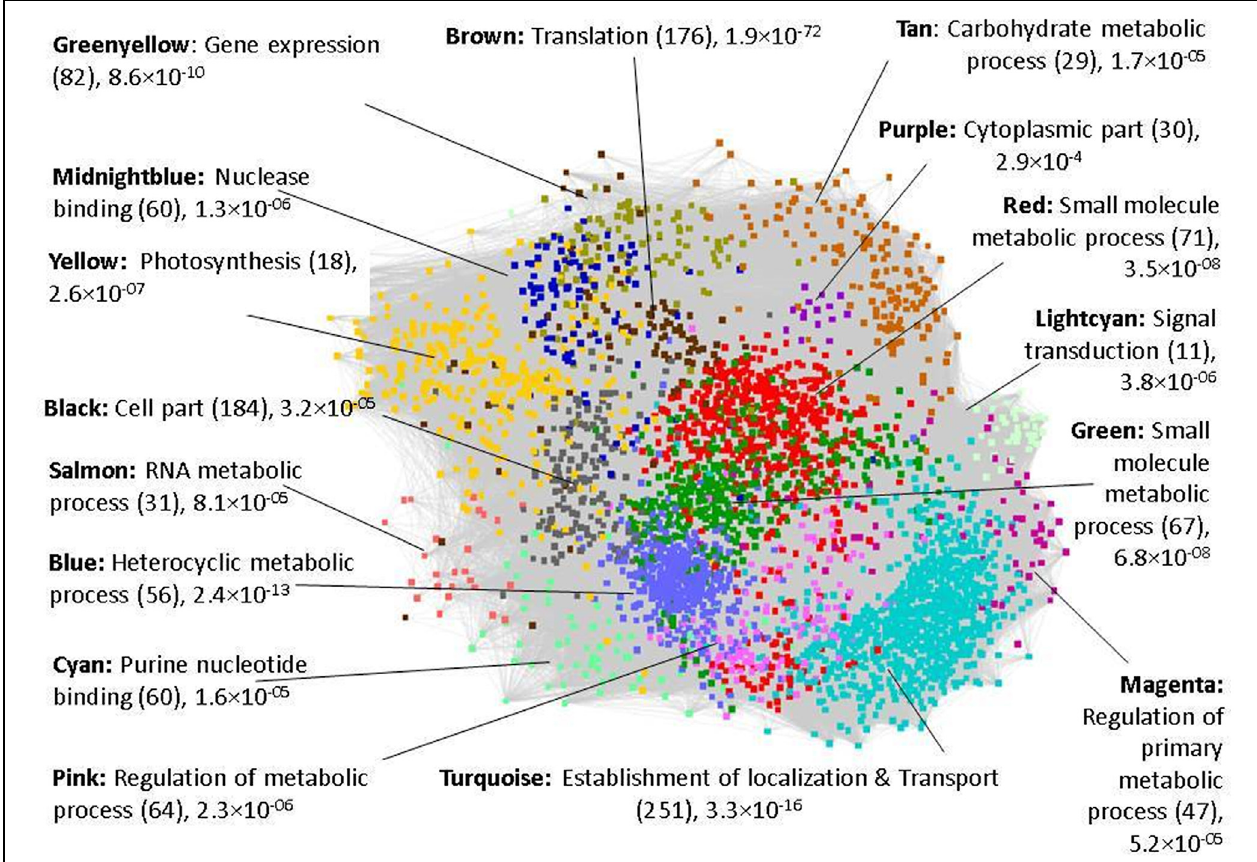
FIGURE 1 | Functional modules with GO enriched terms. The number in bracket corresponds to genes annotated for the top GO term along with the p -value. Only the differentially expressed genes (DEGs) are highlighted for ease of visualization in each module, depicted using a representative color code.